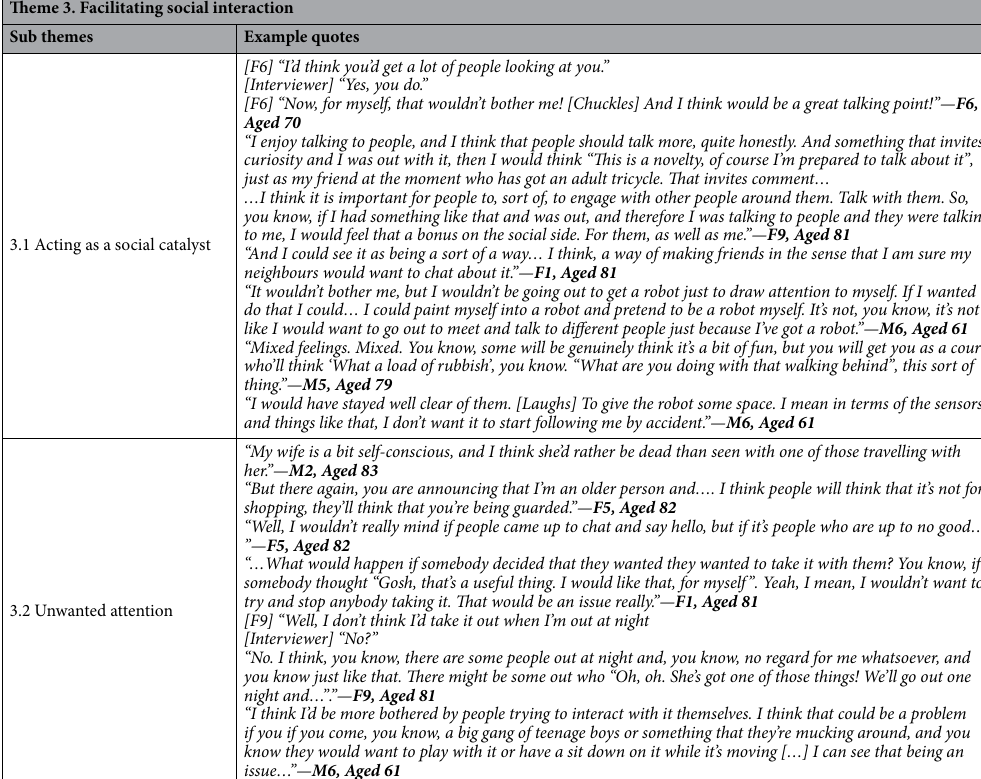
Table 4. Example quotes of Theme 3. Facilitating social